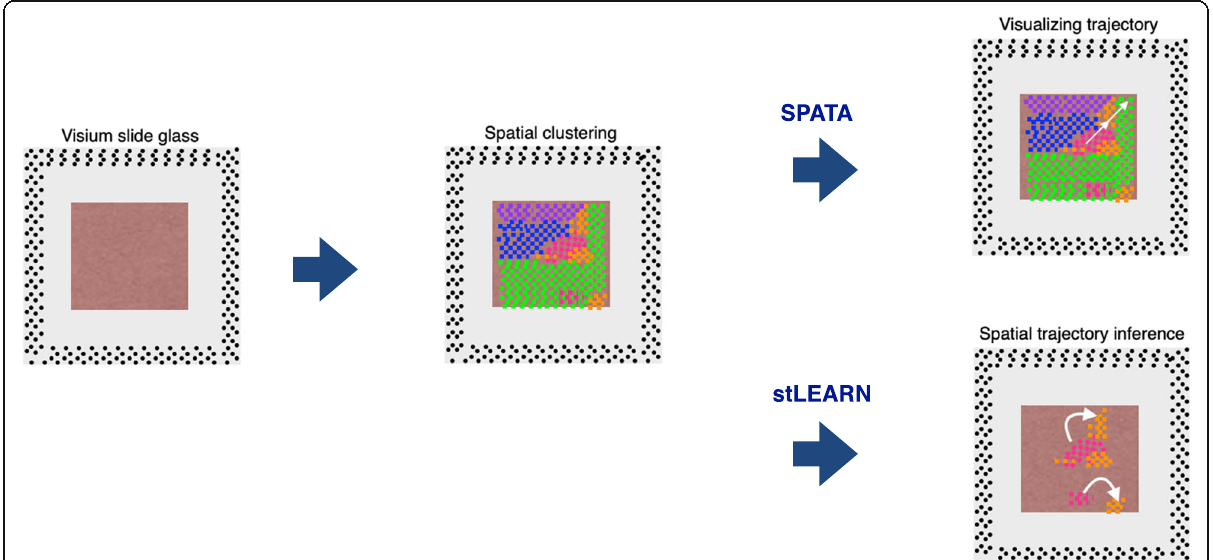
Fig. 5 Tools for Spatial transcriptome analysis. Overview of analysis using SPATA and stLEARN. We can visualize trajectory by SPATA and can estimate spatial trajectory inference by